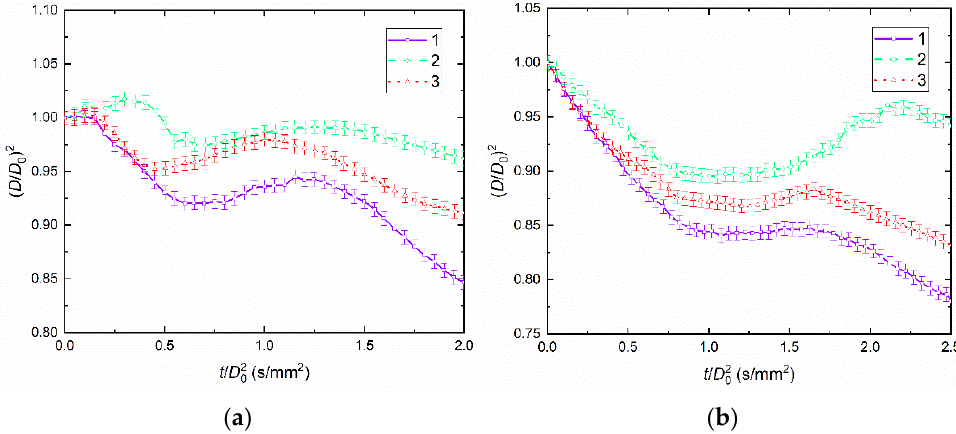
Figure 5. Temporal characteristics of droplet evaporation and drying until breakup for blends K50W49R1 ( a ) and K50W49LE1 ( b ) ( R d0 = 1.3 ± 0.1 mm): 1 — T a = 950 ± 30 K; 2 — T a = 1050 ± 30 K; 3 — T a = 1150 ± 30